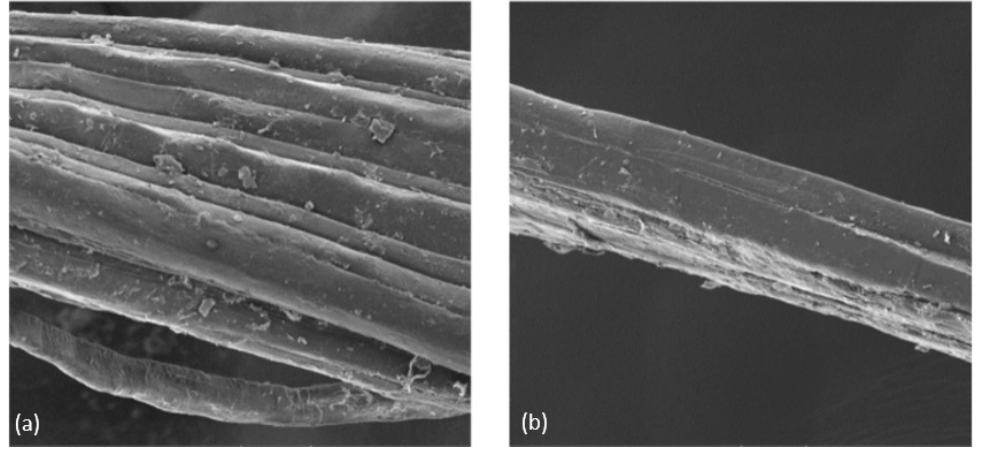
Figure 22. ( a ) Untreated fibre and ( b ) treated fibre.